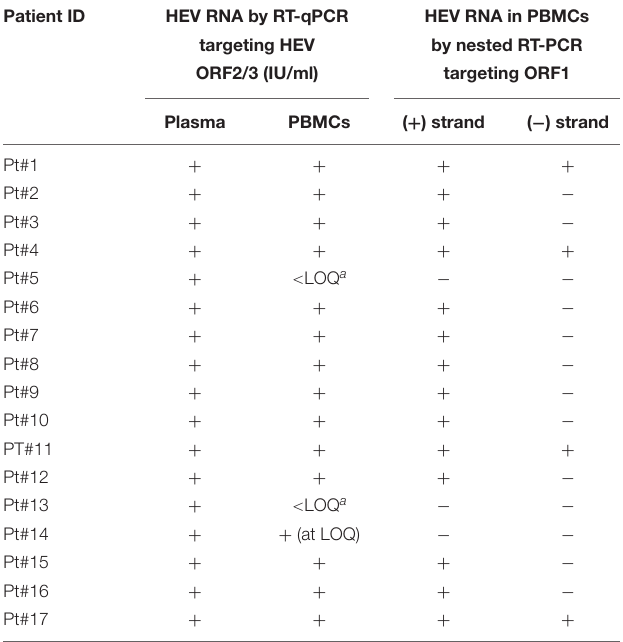
TABLE 1 | Assessment of HEV RNA in the PBMCs of AHE by RT-qPCR and nested PCR. Patient ID HEV RNA by RT-qPCR HEV RNA in PBMCs targeting HEV by nested